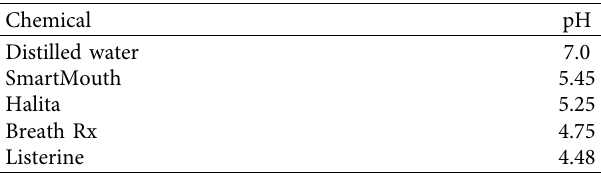
Table 1: pH of each chemical